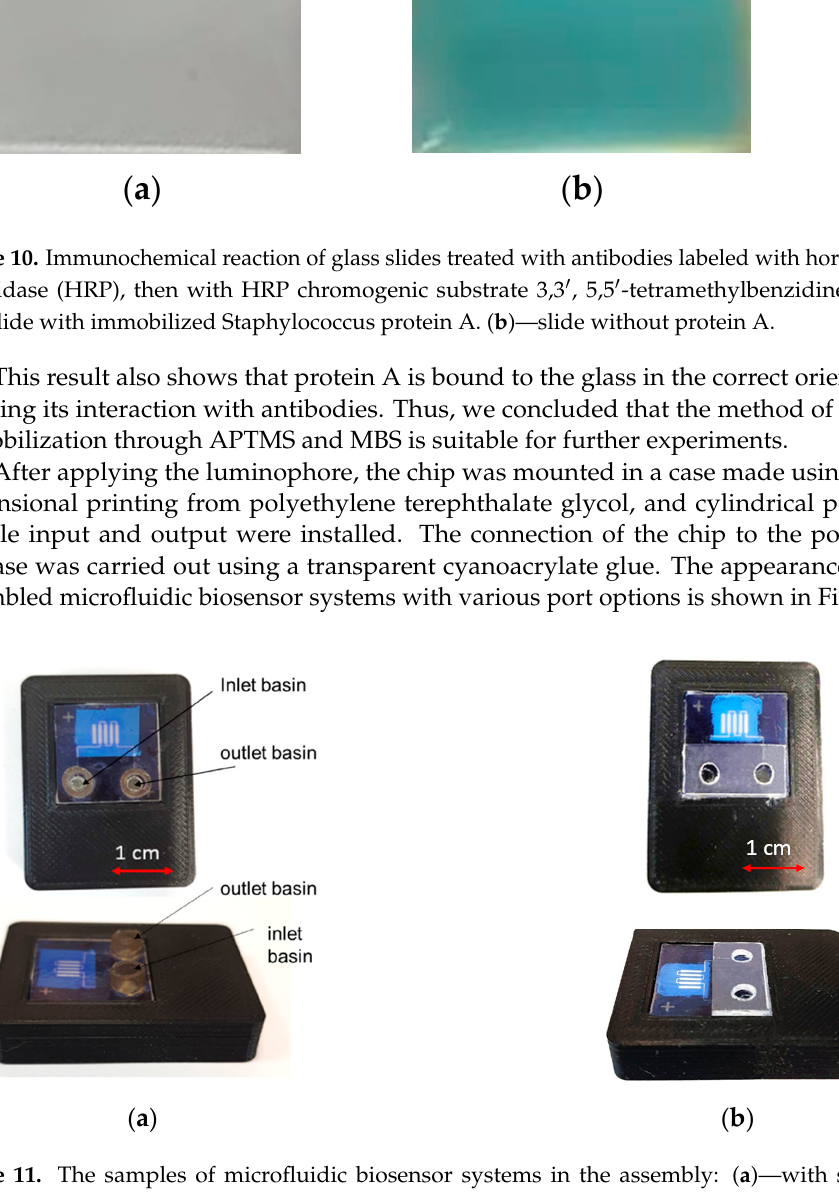
Figure 12. Diagram of the microfluidic biochip manufacturing process, including the stages of heterogeneous integration of a biorecognition element. Thus, the production of a hybrid microfluidic biochip under development includes a set of processes that constructively and technologically integrate substances of various